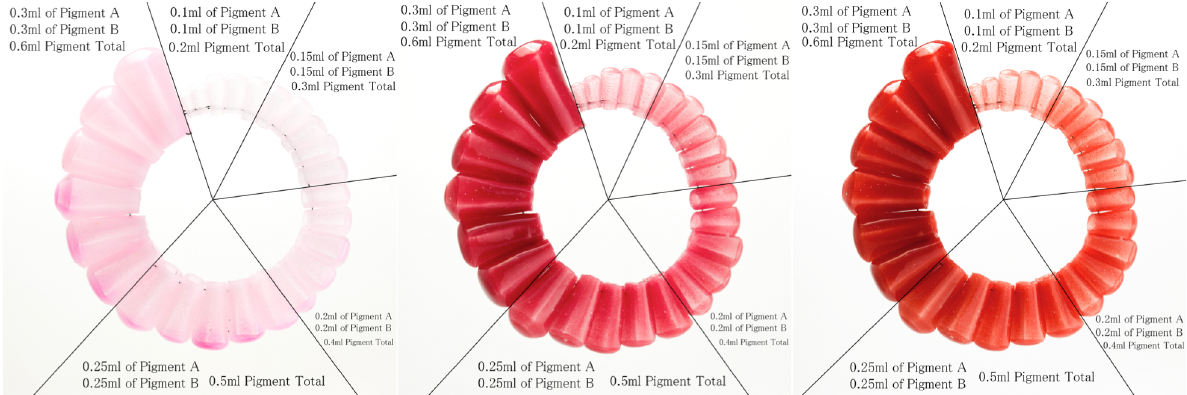
Figure 3 | Example of the progressive stages of change in a dual pigment sample of Magenta 41˚C and Yellow